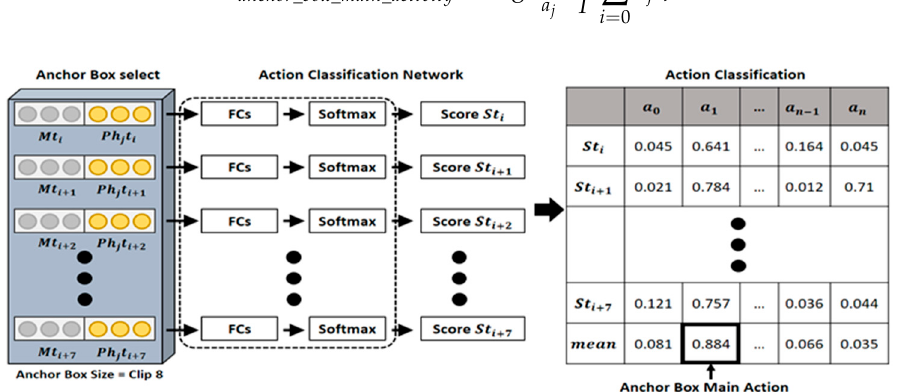
Figure 6. Action classification.